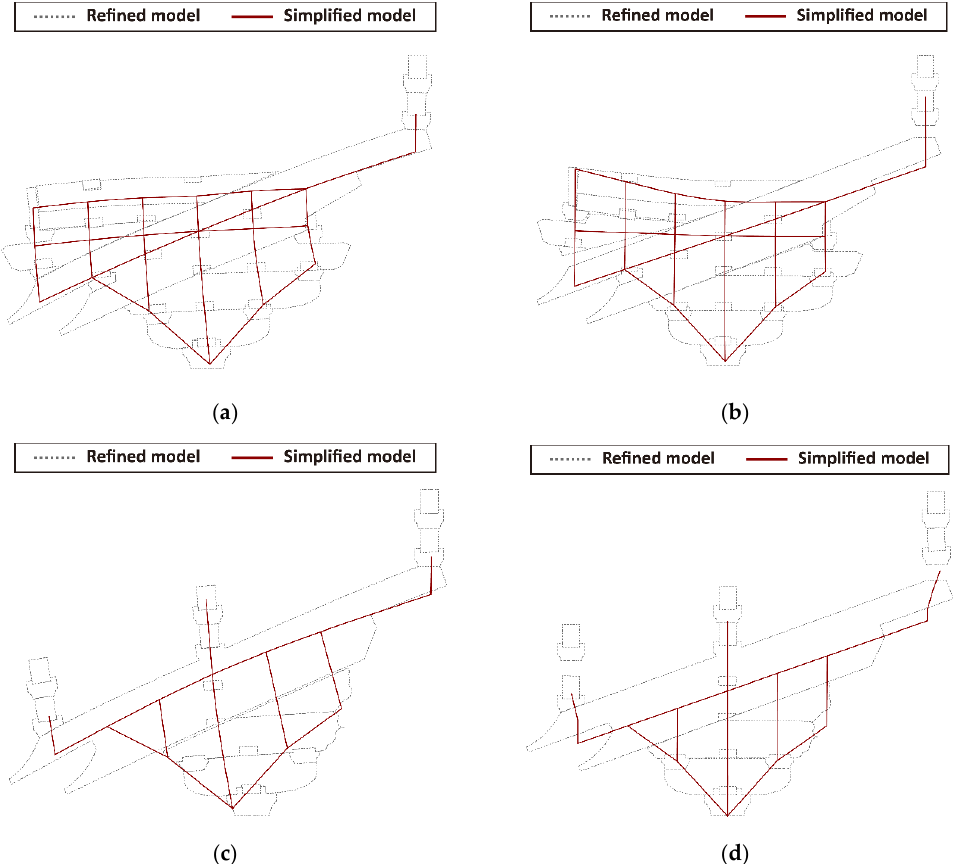
Figure 17. Comparison of the deformation results, refined model vs. simplified model: ( a ) Ji-xin-zao Dou-gong in the roof load condition; ( b ) Ji-xin-zao Dou-gong in the collapse condition; ( c ) Tou-xin-zao Dou-gong in the roof load condition; ( d ) Tou-xin-zao Dou-gong in the collapse condition.